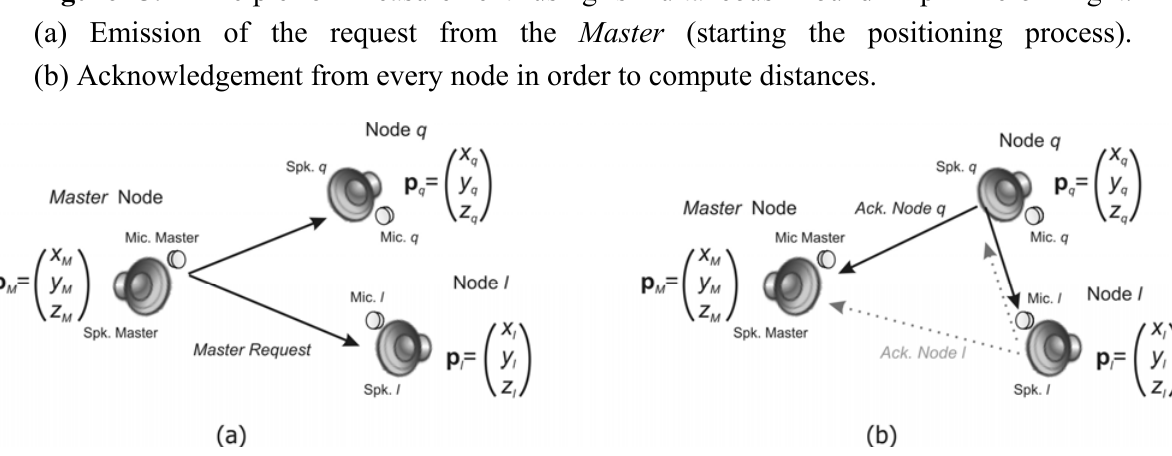
Figure 3. Principle of measurement using simultaneous